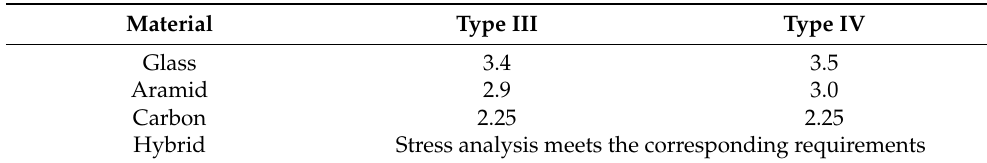
Table 8. Minimum burst pressure ratio according to EC Regulation 406 [175]. Reprinted with permission from Wang et al., International Journal of Hydrogen Energy, published by Elsevier,